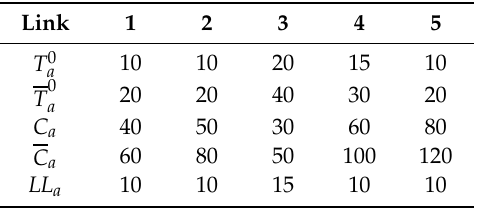
Table 2. Link flows of the nonlinear complementarity problem (NCP) for cases with and without physical separation. Link